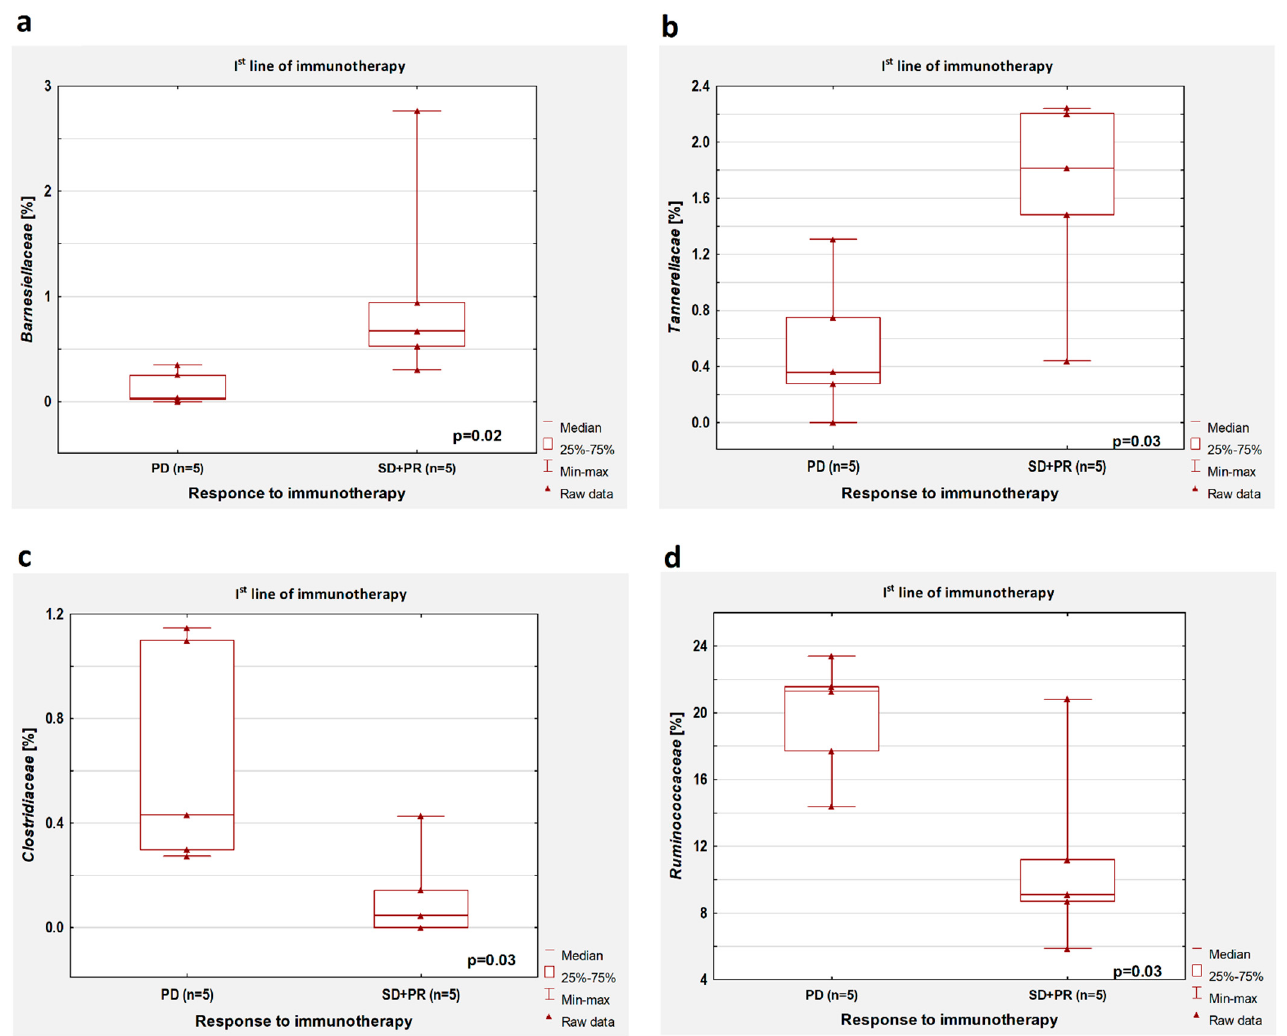
Figure 4. Boxplots showing the content of ( a ) Barnesiellaceae , ( b ) Tannerellaceae , ( c ) Clostridiaceae, and ( d ) Ruminococcaceae in the group of patients with the disease control (SD + PR) and progression disease (PD) during first-line immunotherapy. All results concern the patients untreated with antibiotics before immunotherapy.